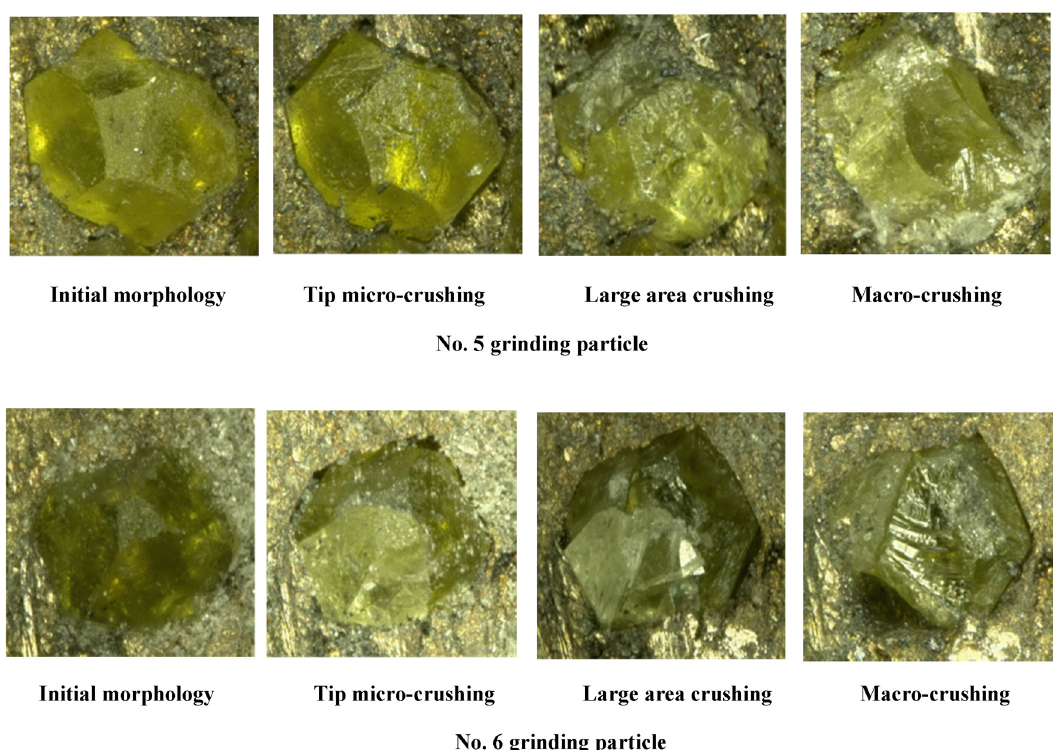
Figure 7: The morphology of the third group of abrasive particles. No. 5 grinding particle and No. 6 grinding particle.